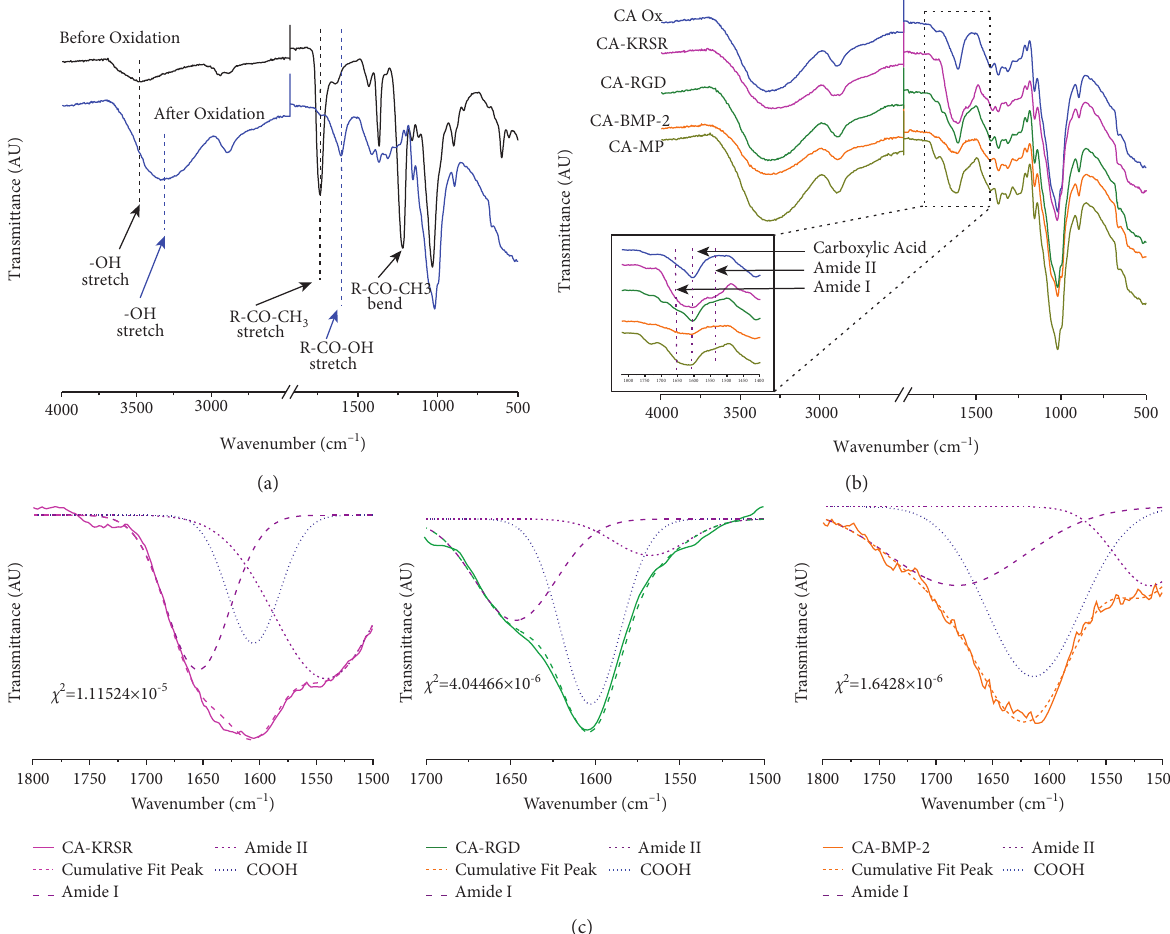
Figure 2: FTIR spectra comparison of the (a) FTIR of CA fiber mat (black) and CA-oxidized (blue) modifications; (b) individual peptide couplings for CA-KRSR (pink), CA-RGD (olive), CA-BMP-2 (orange), and (d) CA-MP (dark yellow); and (c) deconvoluted amide (purple) FTIR peaks using a Gaussian curve fitting function for CA-KRSR (pink), CA-RGD (olive), and CA-BMP-2